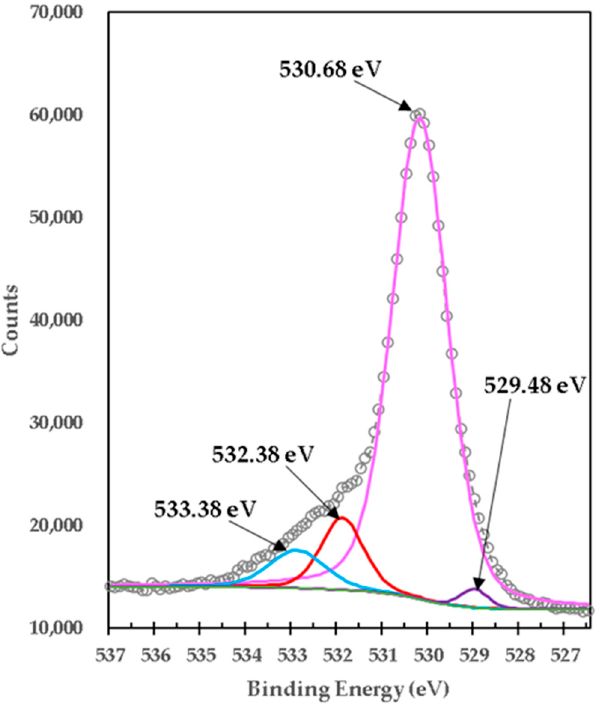
Figure 6. XPS high-resolution spectra of O1s in high-purity titania for formulation M3.